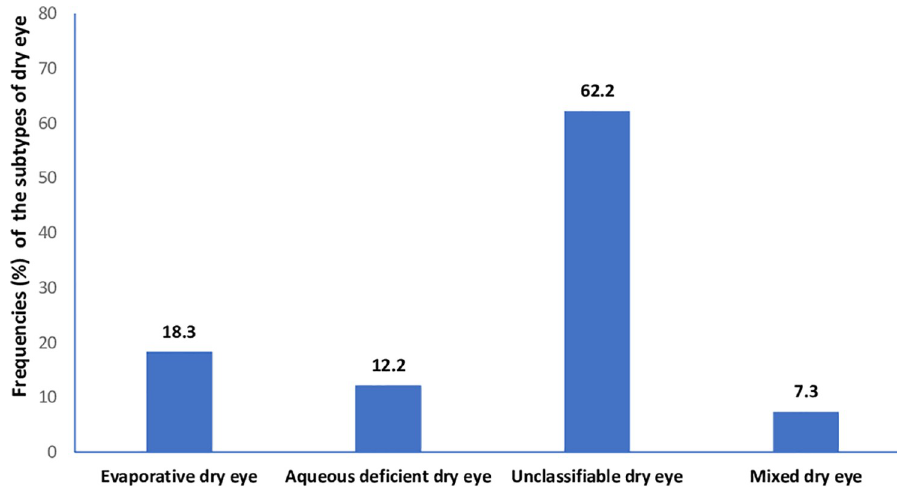
Fig 1. Frequencies of clinical subtypes of dry